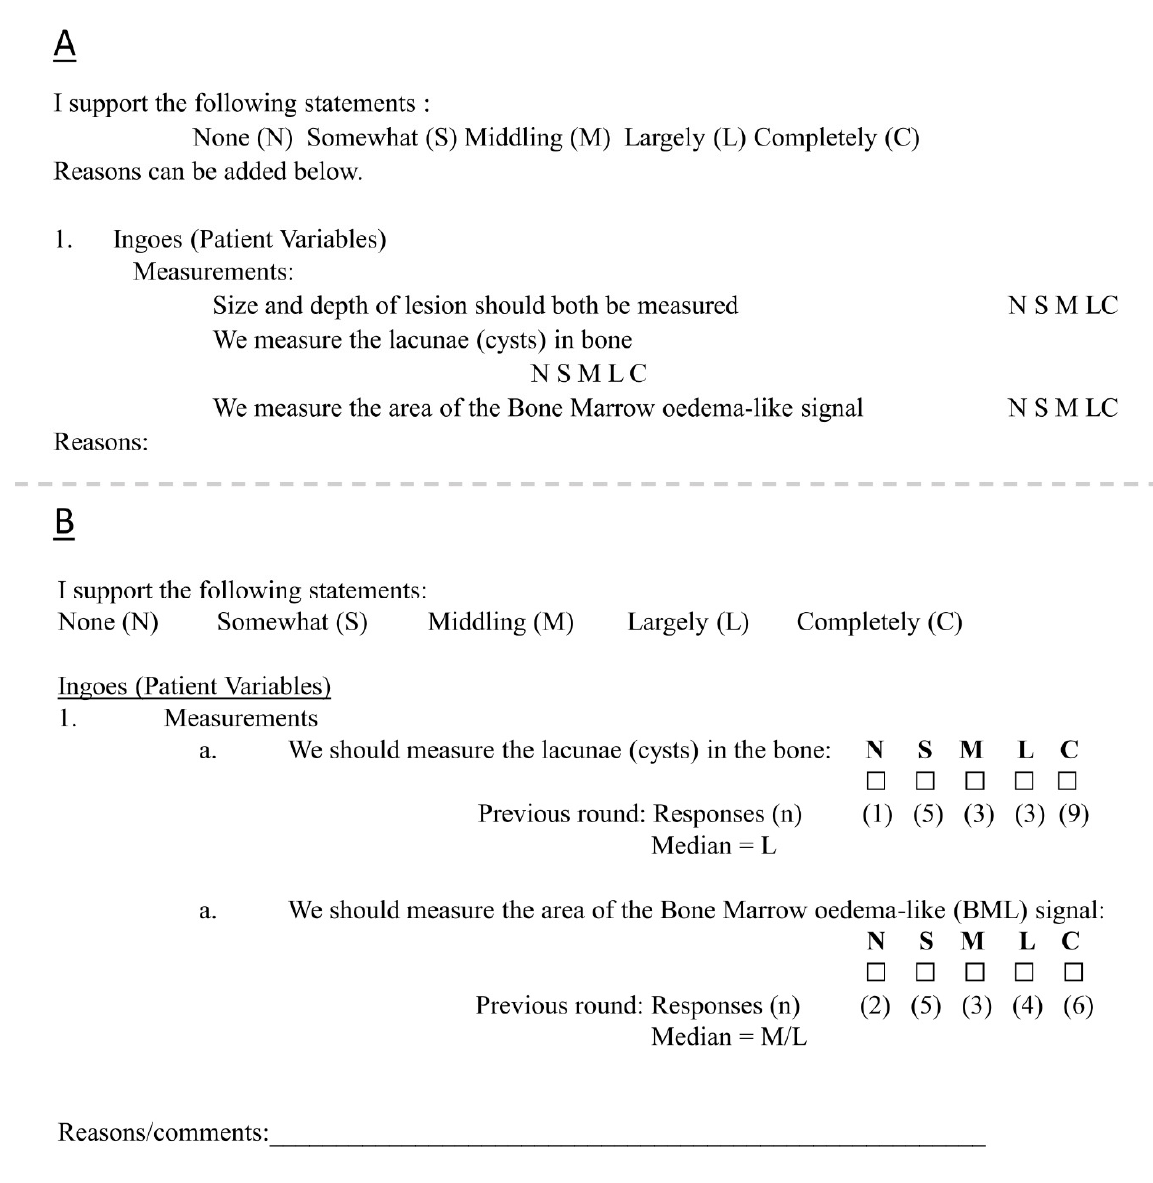
Figure 1. A 5-point Likert scale used to rate agreement with single statements on the round 2 and round 3 questionnaires.